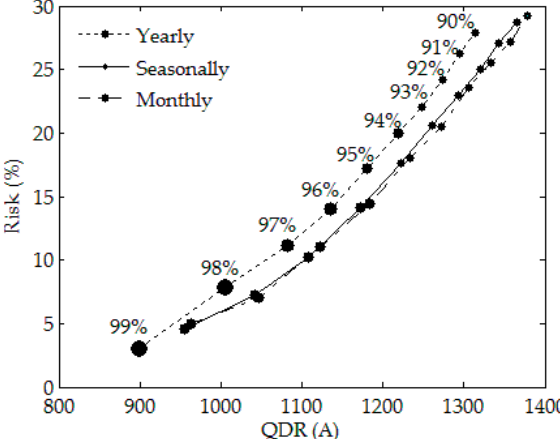
Figure 9. The operation risks of QDR under different time scales and confidence